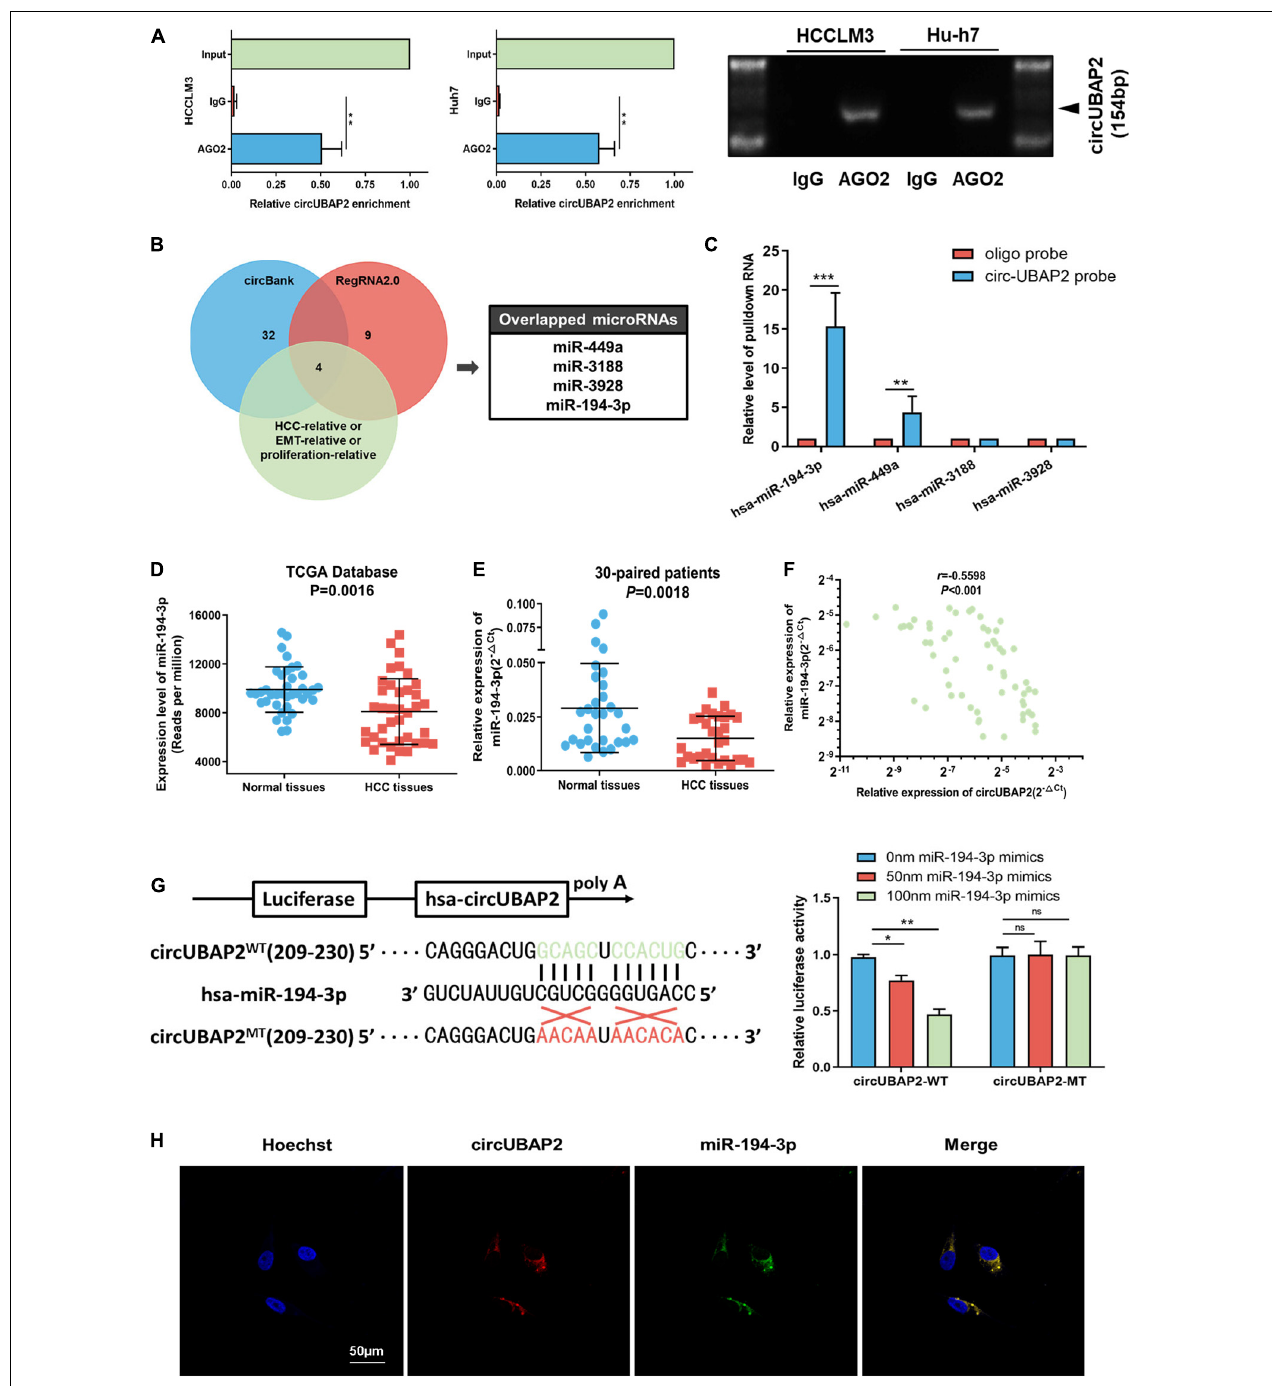
FIGURE 4 | CircUBAP2 functions as a sponge for miR-194-3p. (A) RNA immunoprecipitation (RIP) and RT-qPCR assays were conducted to analyze the binding of circUBAP2 to the AGO2 protein. (B) Bioinformatics analysis was performed for predicting and filtering possible miRNA candidates. (C) CircRNA-pulldown assays were performed using circUBAP2-specific biotin probe and oligo probe. RT-qPCR assays were performed to analyze potential miRNAs associated with circUBAP2. The enrichment of potential miRNAs was normalized to that of the control probe. (D) TCGA database shows that the expression of miR-194-3p is reduced in HCC tissues. (E) The expression level of miR-194-3p was further assessed in 30 HCC tissues and paired normal tissues. (F) CircUBAP2 level was negatively correlated with miR-194-3p levels, which was validated by RT-qPCR in 30 HCC tissues. The correlation was evaluated by Pearson correlation analysis. (G) Wild-type (WT) and mutated-type (MT) sequences of the putative binding sites between circUBAP2 and miR-194-3p. Luciferase activity in HA22T cells co-transfected with luciferase reporters containing circUBAP2 sequences with wild-type or mutated miR-194-3p binding sites and mimics of miR-194-3p or controls. (H) The FISH experiments showed that circUBAP2 and miR-194-3p colocalized in the cytoplasm. Scale bar = 50 µ m. ns means P > 0.05, * P > 0.05, ** P > 0.01 and *** P > 0.001.